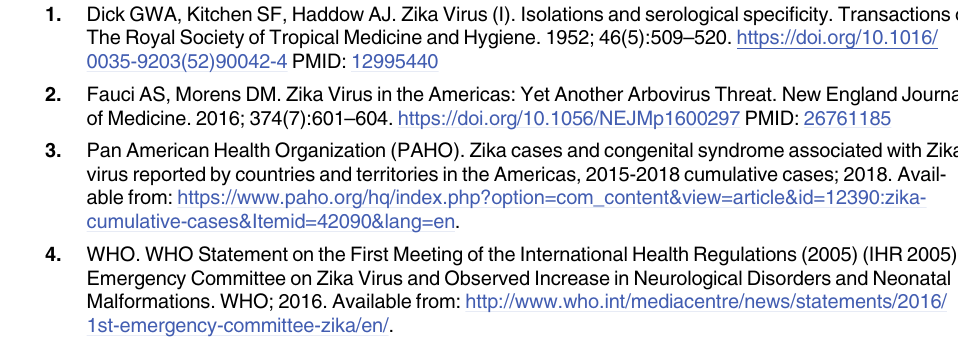
S42 Fig. Posterior distributions of national and subnational ZIKV infection attack rates (IAR) for Panama when each of the different data types is withheld from the model fitting process. (TIF) S43 Fig. Posterior distributions of national and subnational ZIKV infection attack rates (IAR) for Guatemala from models fit to a single data type in comparison to the full model fit to all data types. (TIF) S44 Fig. Posterior distributions of national and subnational ZIKV infection attack rates (IAR) for the Dominican Republic from models fit to a single data type in comparison to the full model fit to all data types. (TIF) S45 Fig. Posterior distributions of national and subnational ZIKV infection attack rates (IAR) for Panama from models fit to a single data type in comparison to the full model fit to all data types.